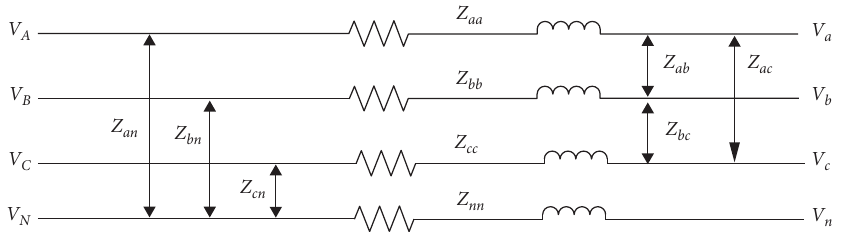
Figure 1: Tree-phase branch section model.